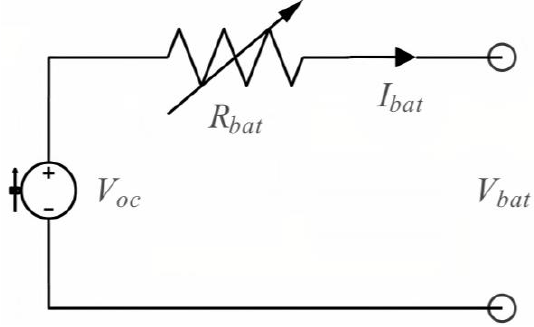
Figure 3. Thévenin equivalent circuit of the battery model. Figure 3. Th é venin equivalent circuit of the battery model.